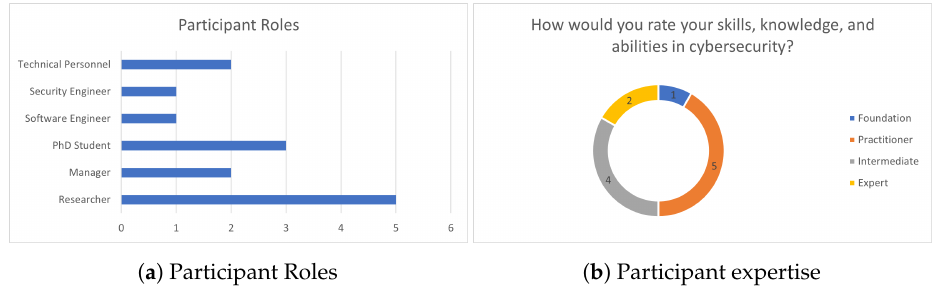
Figure 15. Participant roles ( a ) and cyber-security expertise ( b ).